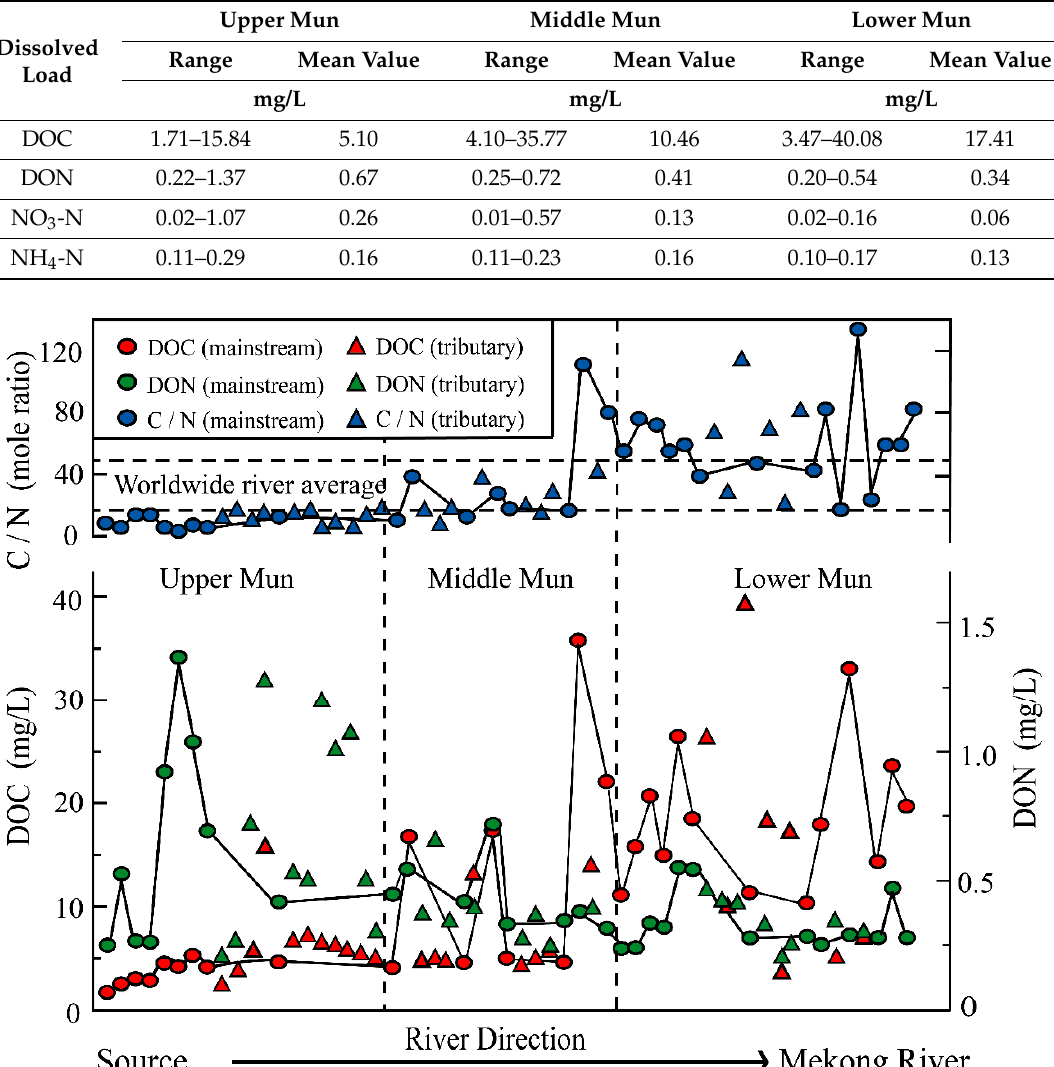
Table 2. Distributions of DOC and N species in the Mun River.